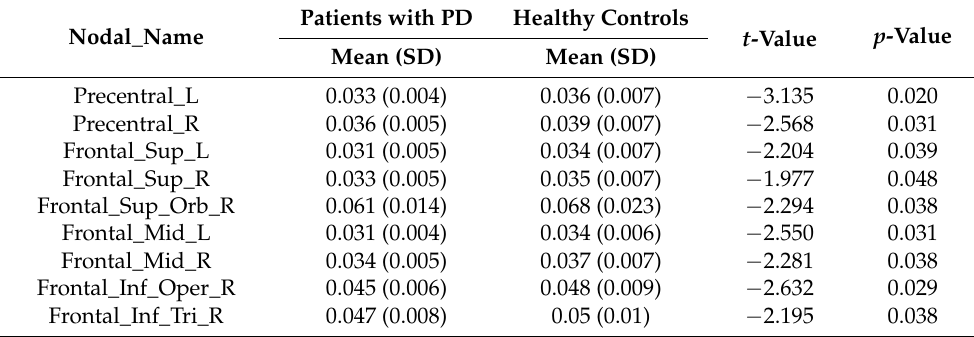
Figure 2. Differences in global and nodal efficiencies between HC and PD groups. ( A ) * showed s ignificant differences in global efficiency between HC and PD groups. ( B ) Nodes, which showed a significant group-wise difference in nodal efficiency. The size of nodes refers to the magnitude of nodal efficiency. ( C ) ROC curve for the logistic model of global efficiency, the optimal threshold leads to a specificity of 0.542 and a sensitivity of 0.765. Table 3. Nodal average shortest path